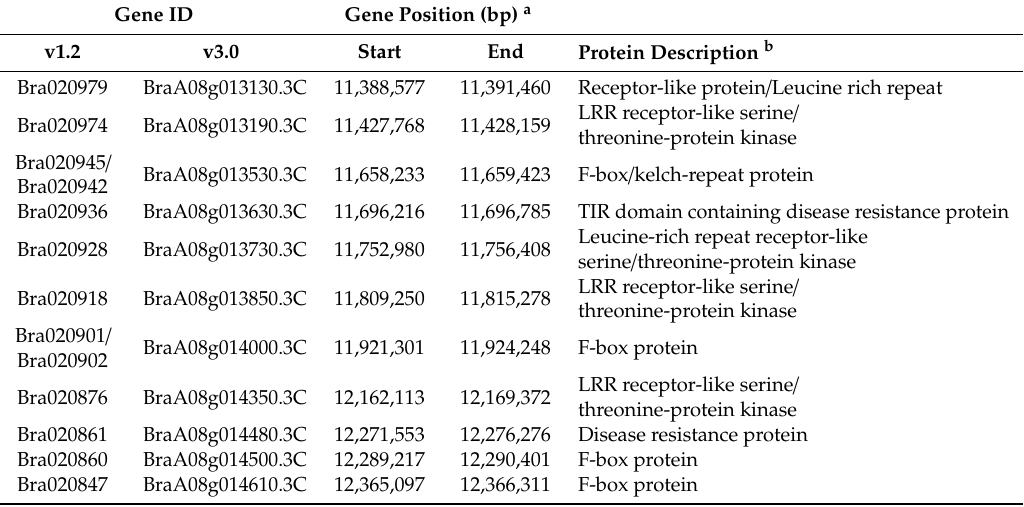
Table 3. Identification of related resistance genes within the PbBrA08 Banglim region in B . rapa .